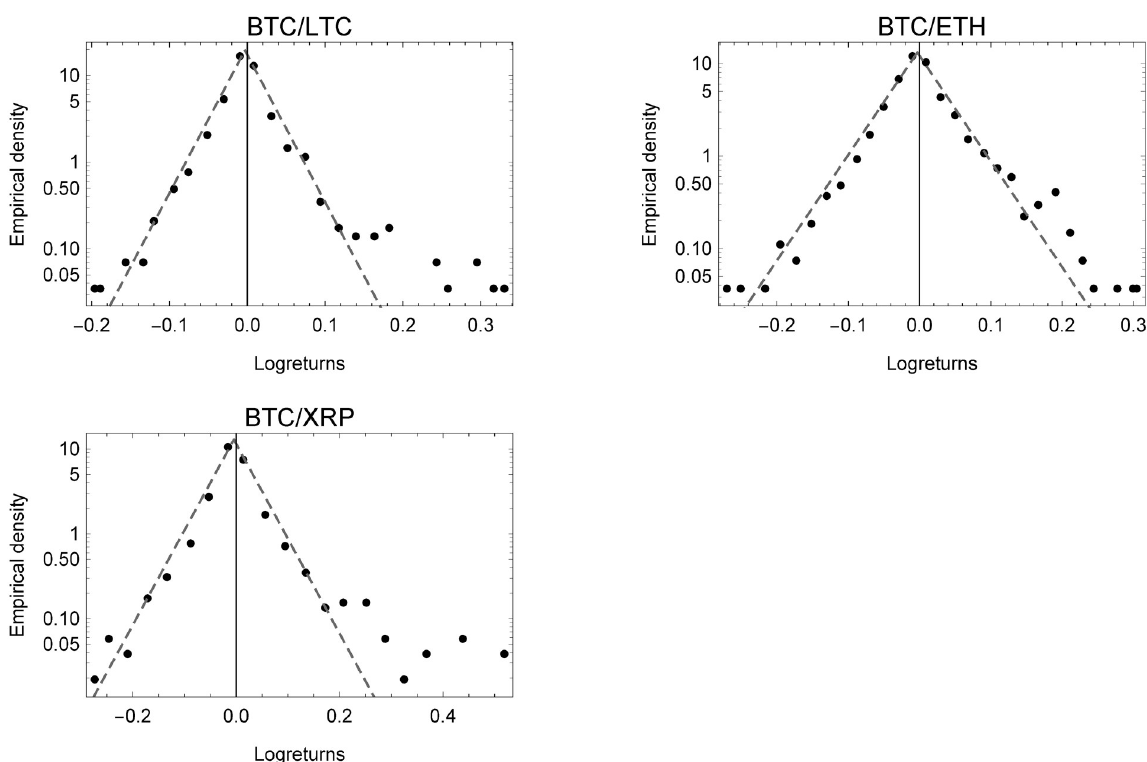
Fig 2. Empirical densities of intra-virtual currencies. Empirical densities of currency exchange rate log-returns for the intra-virtual currencies.